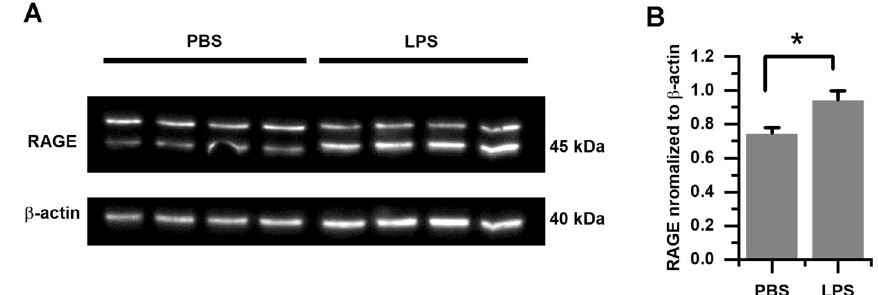
Figure 5. In vivo LPS instillation increased RAGE expression in WT mice. ( A ) Immunoblot showing levels of RAGE expression, and the loading control β-actin, in whole tDRGs from LPS-treated mice compared to PBS- treated controls. ( B ) Bar graphs show the mean ± SEM levels of RAGE protein after normalization to β-actin. Data represented as mean ± SEM. Means were statistically compared by Mann–Whitney test. *p <